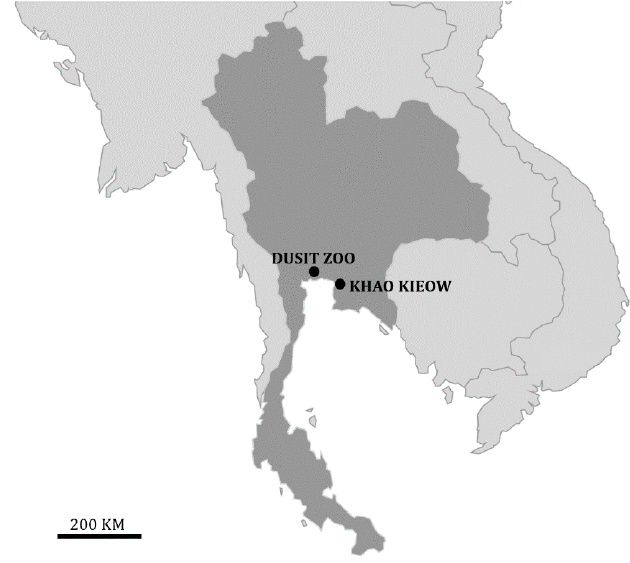
Figure 1. Location of the study sites (Thailand).